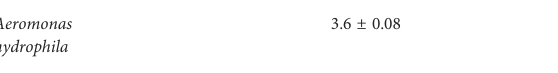
TABLE 3 Hemolysin assay of Aeromonas hydrophila isolated from diseased Pangasianodon hypophthalmus . Bacterial species Ratio clear zone and colony diameter (mm) Aeromonas hydrophila